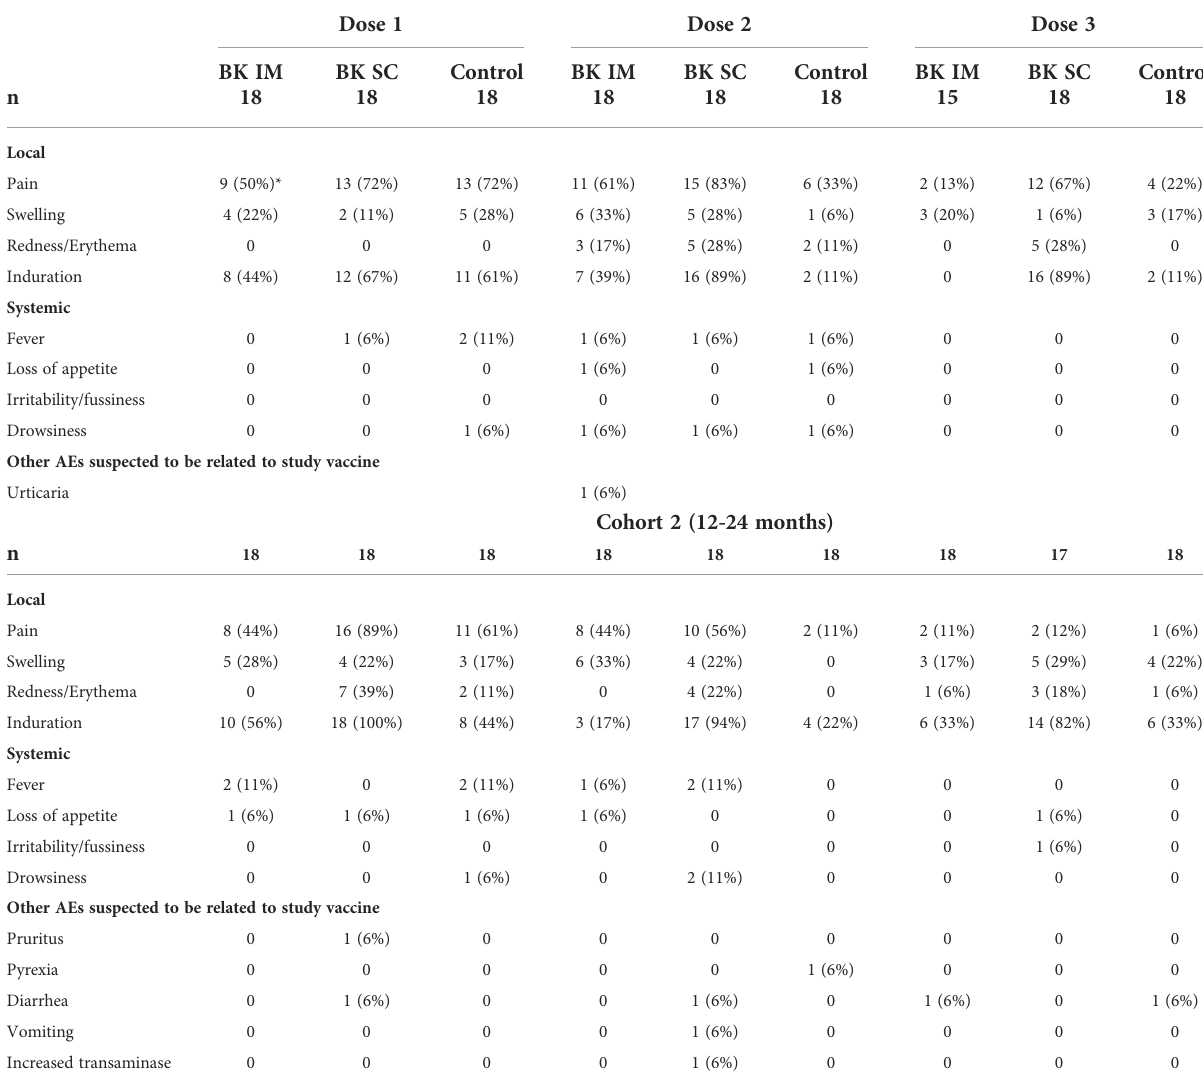
TABLE 2 Summary of local and systemic adverse events (full analysis